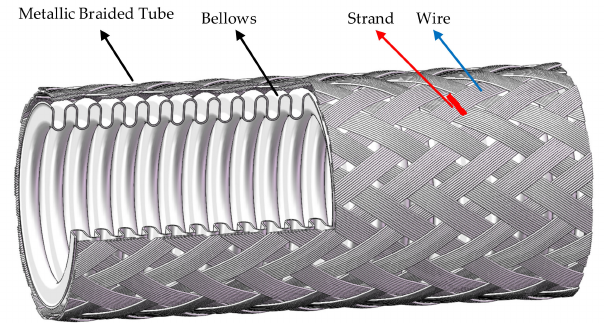
Figure 2. The braided corrugated